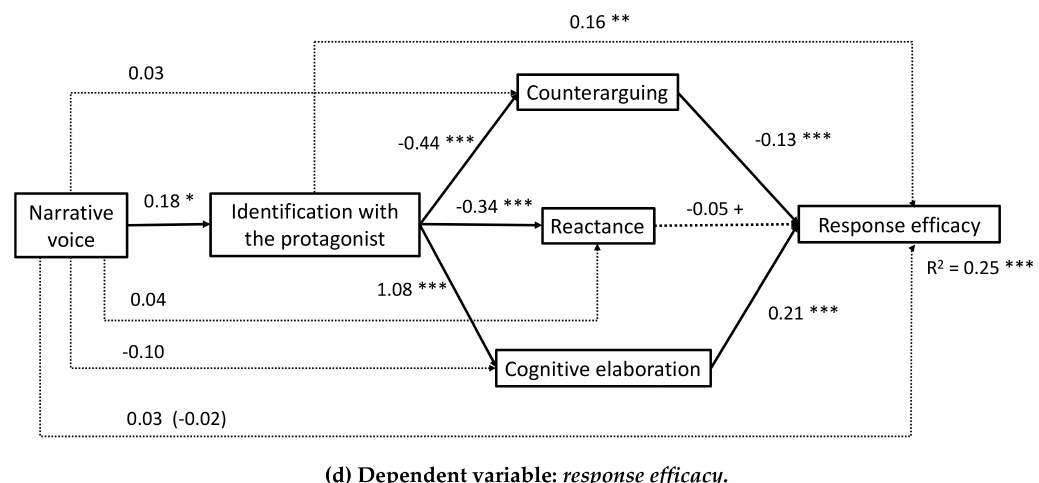
Figure 2. Results of the mediation analysis (H2). The figures show the non-standardized regression coe ffi cients, B . The coe ffi cients of the direct e ff ects appear in parentheses. The dashed line represents nonsignificant coe ffi cients. + p < 0.10, * p < 0.05, ** p < 0.01, *** p < 0.001. ( a ) Dependent variable: perceived message e ff ectiveness . ( b ) Dependent variable: intention to quit . ( c ) Dependent variable: self-e ffi cacy . ( d ) Dependent variable: response e ffi cacy